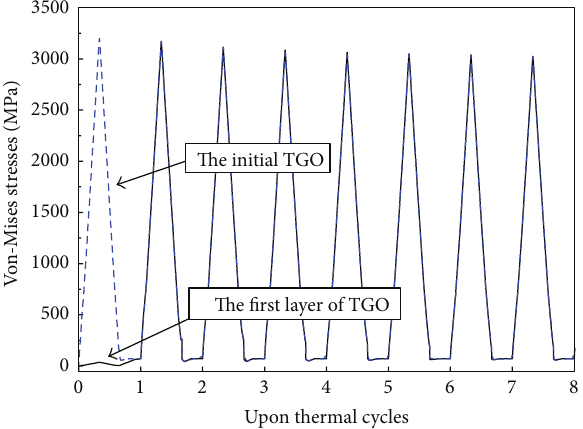
Figure 12: The variation of Von-Mises stress in the initial TGO and in the first layer of TGO with the previous eight